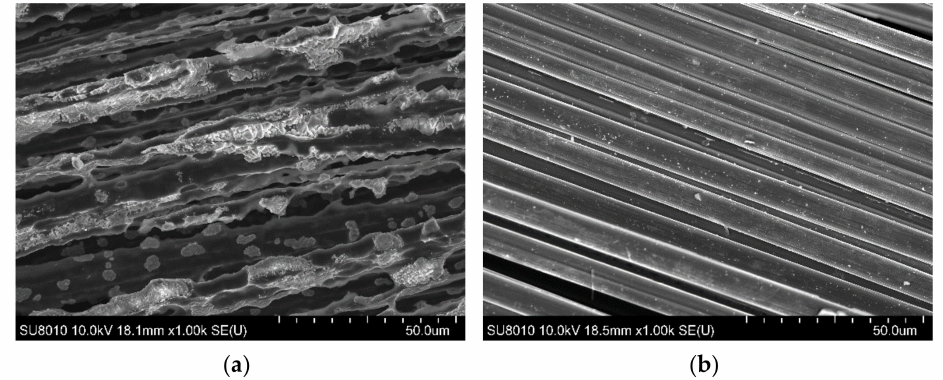
Figure 8. SEM images of A ( a ) and C ( b ) fabrics after fire tests.